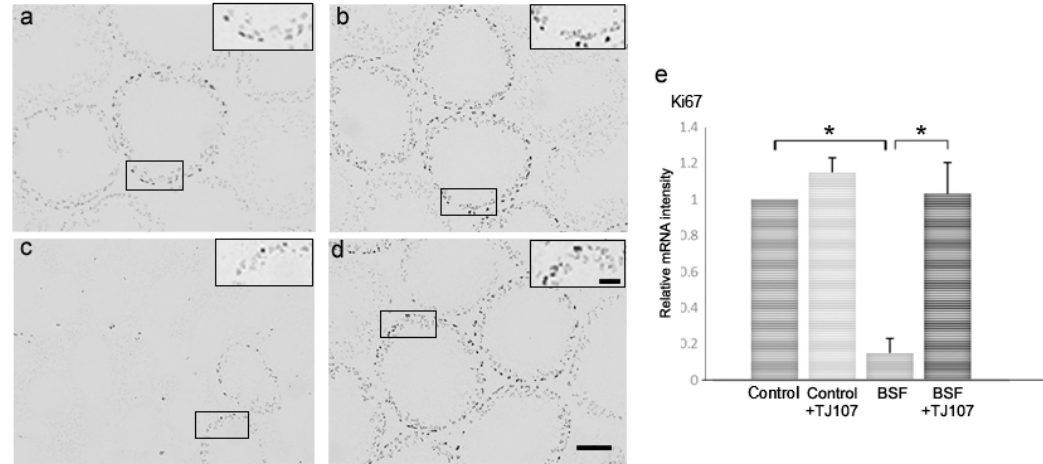
Figure 3. Detection of proliferating cells in the testes using antibodies against Ki67 nuclear antigen at day 120 in the control ( a ), control+TJ107 ( b ), BSF ( c ), and BSF+TJ107 groups ( d ). The enlarged part (Bar: 40 µm) of the seminiferous tubules is bounded by solid frames and is shown in the top right corner in each testis section. Ten testes from each group were examined. Dark brown spots indicating Ki67-positive nuclei of proliferating spermatogonia are detected in almost all seminiferous tubules in the control ( a ), control+TJ107 ( b ), and BSF+TJ107 ( d ) groups at day 120. Most germ cells are destroyed and few seminiferous tubules with Ki67-positive cells are sporadically observed in the BSF group ( c ). Bar: 40 µm. ( e ) Expression of Ki67 in testicular tissues of mice from each group ( n = 10). Asterisks indicate p < 0.05.